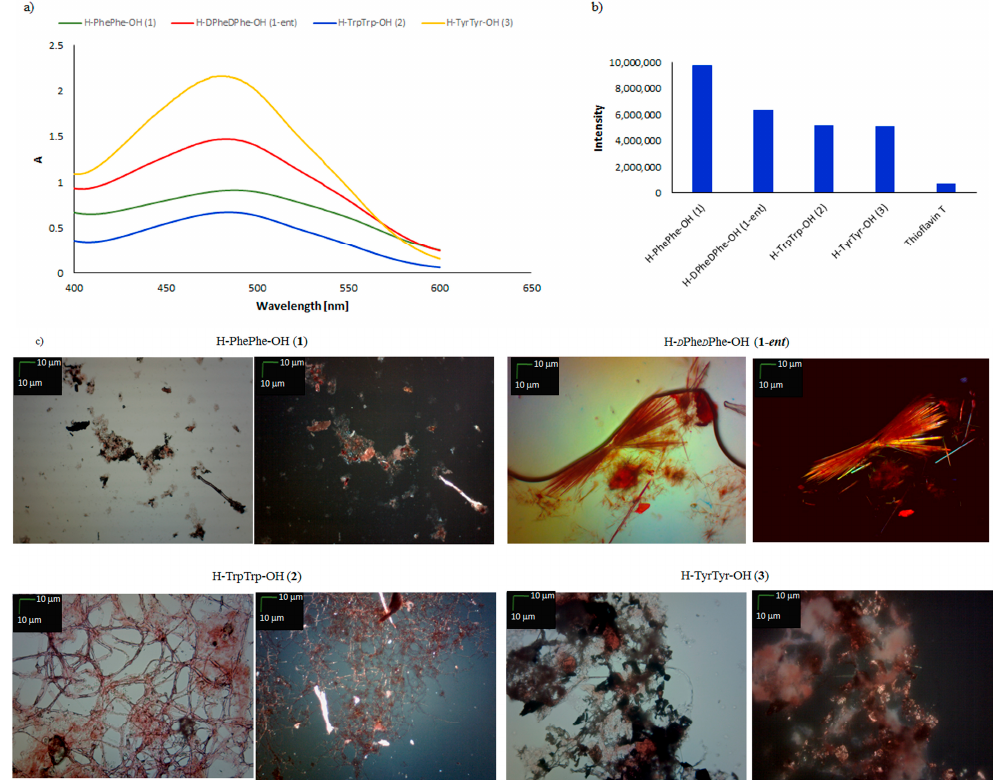
Figure 1. ( a ) UV-Vis spectra of Congo Red (CR) in the presence of H–PhePhe–OH ( 1 ), H– D Phe D